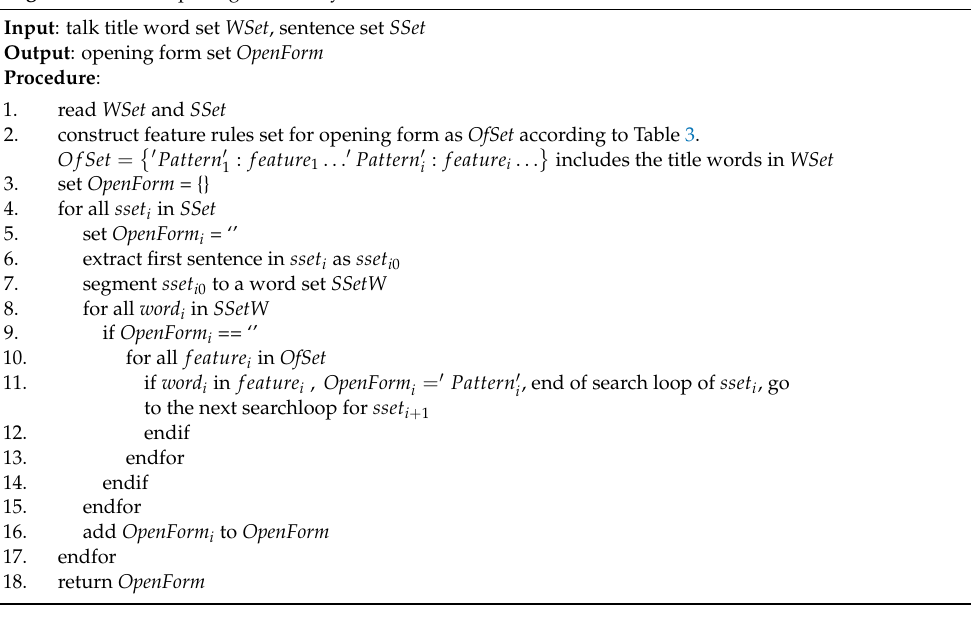
Algorithm 3. Talk opening form analysis.